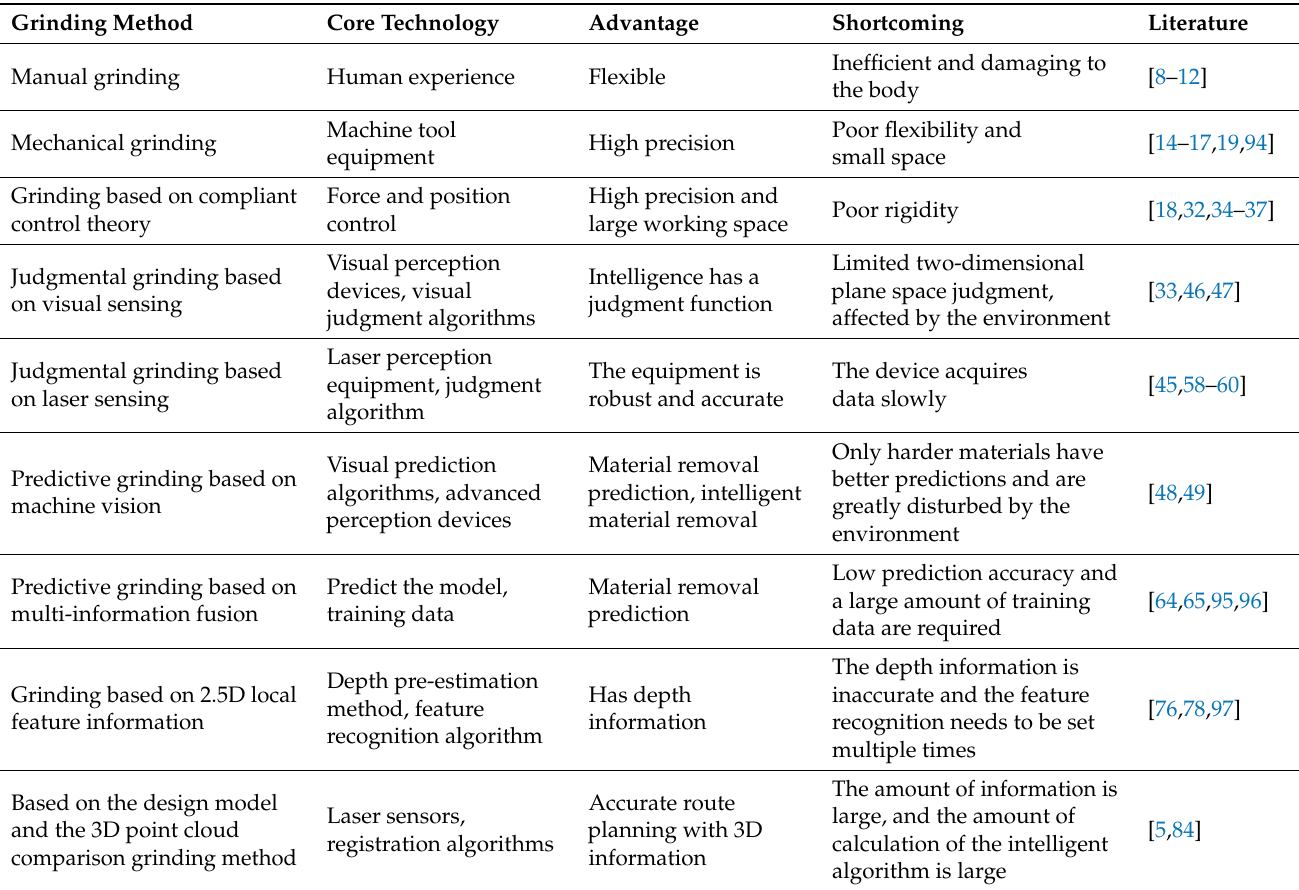
Table 2. Comparison of grinding